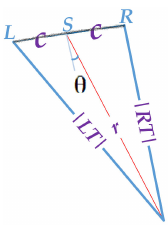
Figure 8. Solving the squint angle of antenna pointing using the triangle midline